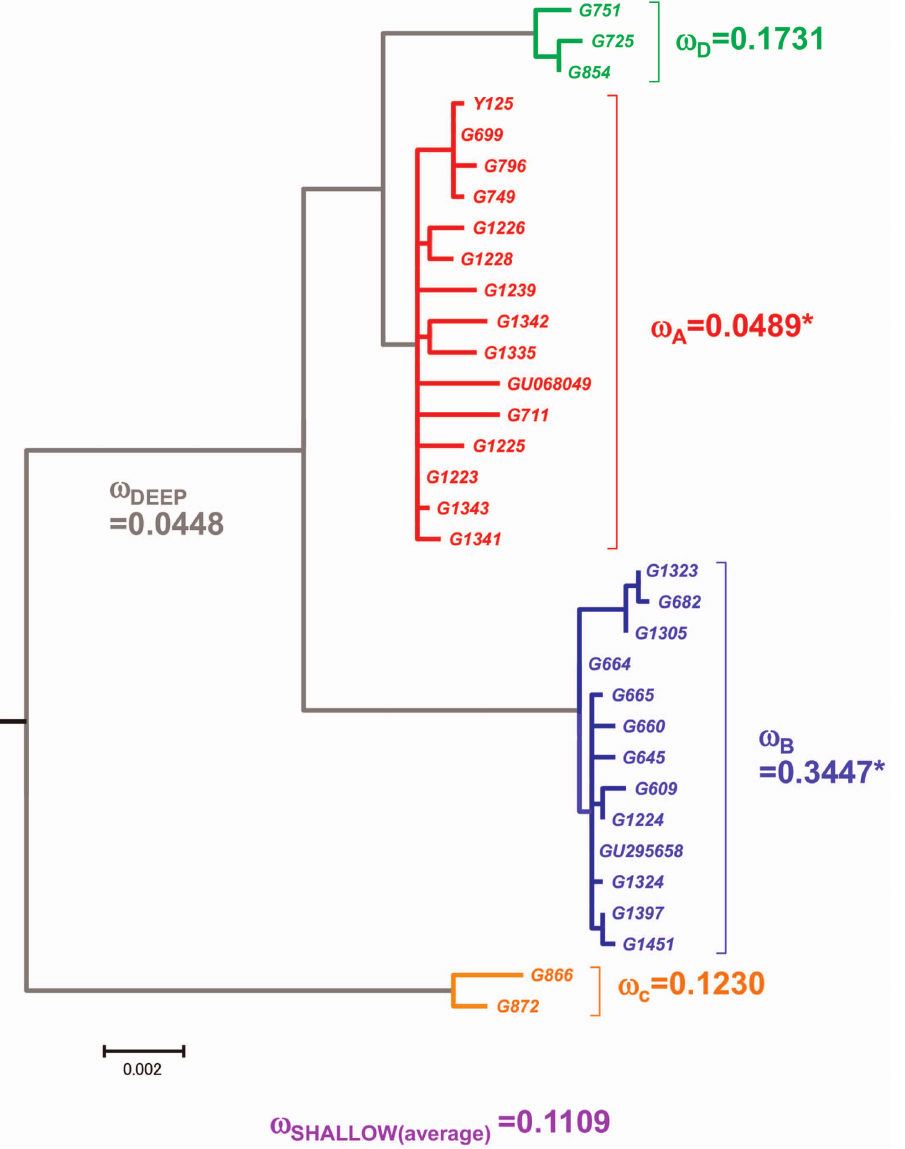
Figure 3. Differences of v ratios among goat lineages based on the smaller data set of nearly complete mitochondrial protein encoding genes. The branch model analysis assuming different v ratios in the shallow branches (a); and the branch model analysis assuming different v ratios in the deep branches (b). Branch lengths are proportional to the numbers of codon substitutions.